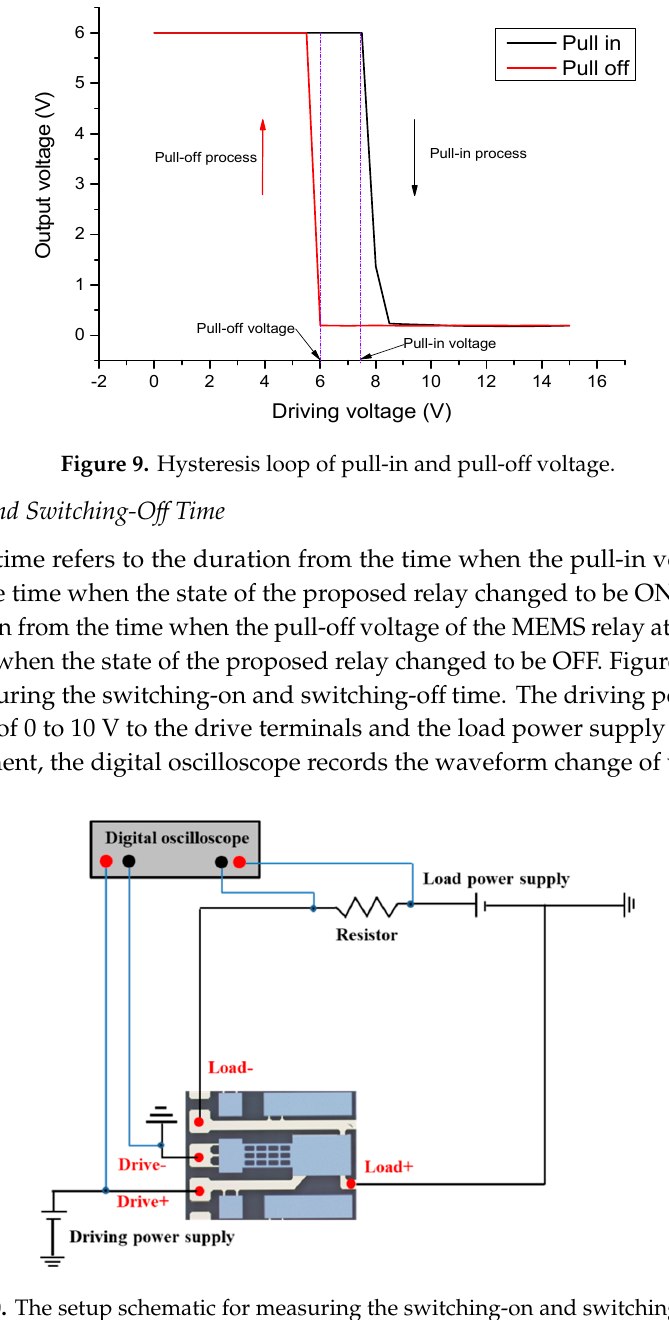
Figure 10. The setup schematic for measuring the switching-on and switching-off time.